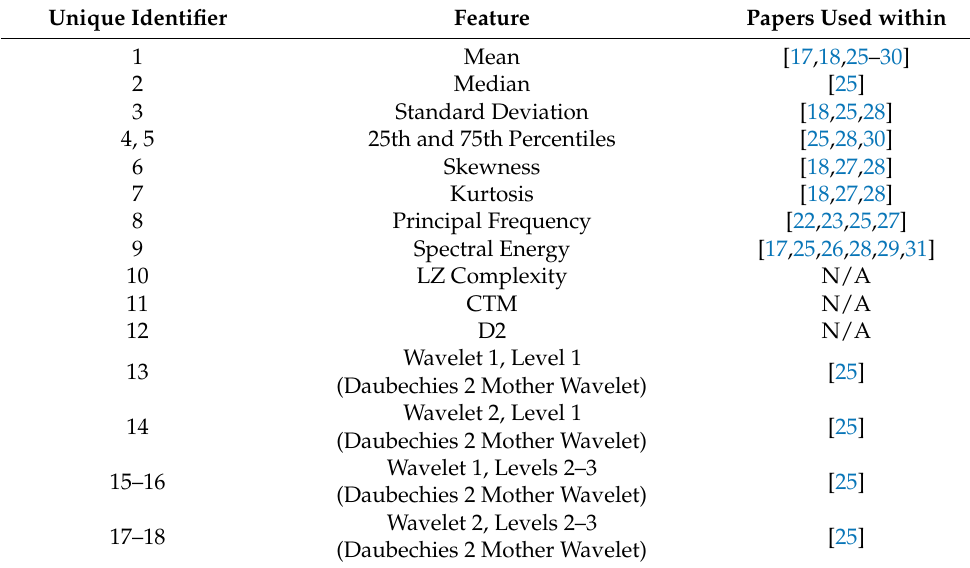
Table 2. List of features extracted from the pre-processed data set, traced throughout this report using a unique identifier and linked to research papers each feature is used